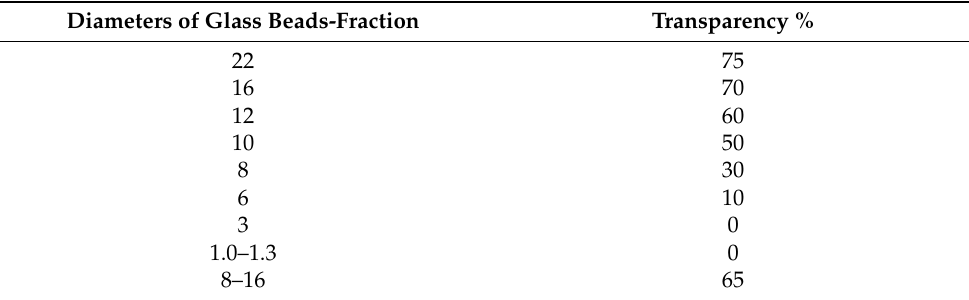
Table 1. Test transparency of technical glass beads.